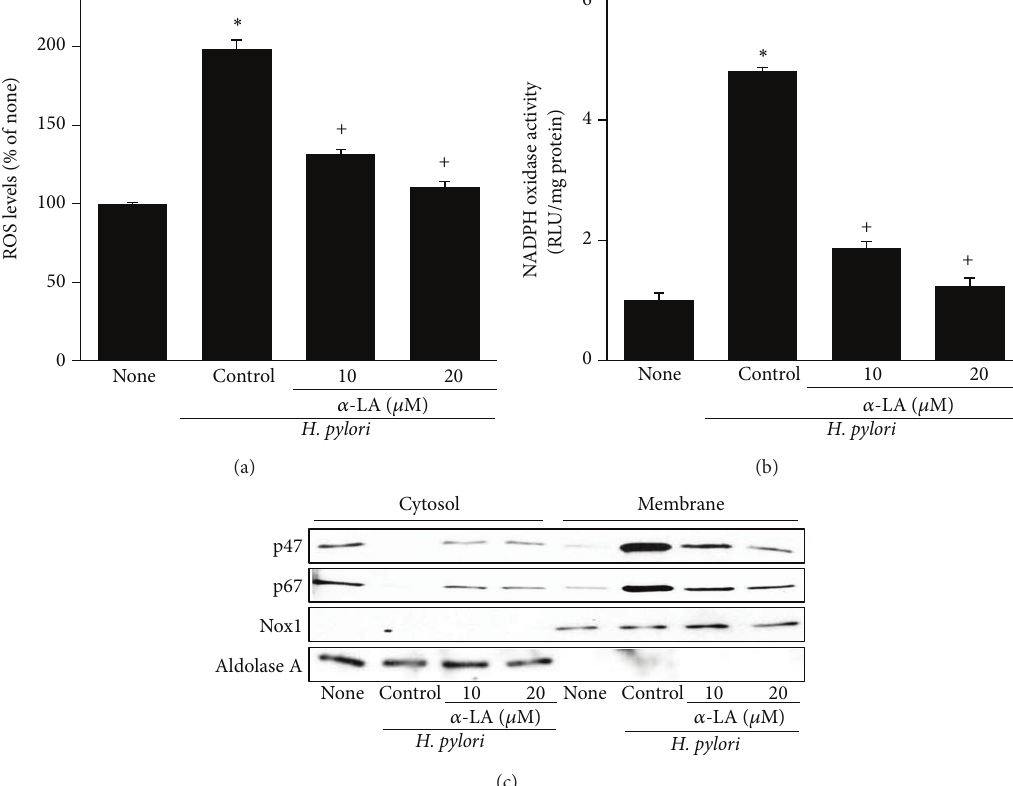
Figure 4: Effect of 𝛼 -LA on ROS levels, NADPH oxidase activity, and levels of NADPH oxidase subunits in H. pylori- infected AGS cells. The cells were pretreated with 𝛼 -LA for 2 h and cultured in the presence or absence of H. pylori. (a) ROS levels were determined by DCF fluorescence after 30 min of H. pylori infection. The levels of ROS trapped in the cells treated without DPI and cultured in the absence of H. pylori are considered as 100%. (b) NADPH oxidase activity was determined by lucigenin assay using membrane extracts of the cells. NADPH oxidase activity was also monitored by addition of cytosolic extracts to the reaction mixture as a negative control. (c), Protein levels of NADPH oxidase subunits (p47, p67) in cytosolic and membrane extracts were determined by Western blotting. Aldolase A and Nox1 were used as indices for cytosol and membrane, respectively. ∗ 𝑃 < 0.05 versus none (the cells cultured in the absence of H. pylori ); + 𝑃 < 0.05 versus control (the cells cultured in the presence of H. pylori and treated without 𝛼